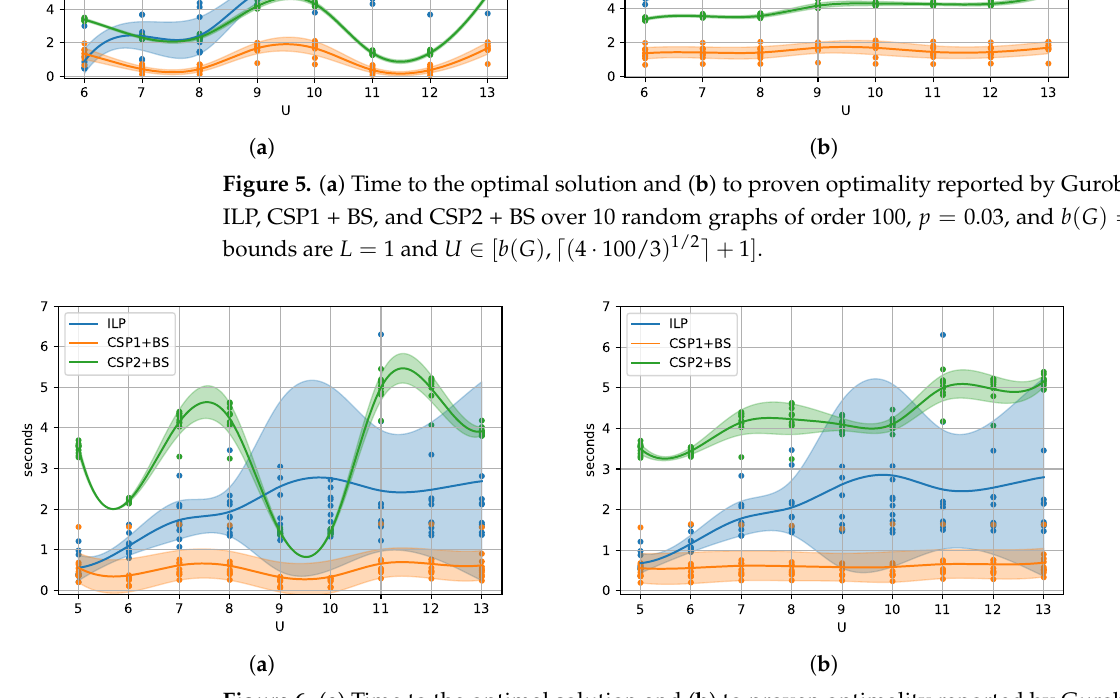
Figure 6. ( a ) Time to the optimal solution and ( b ) to proven optimality reported by Gurobi for the ILP, CSP1 + BS, and CSP2 + BS over 10 random graphs of order 100, p = 0.04, and b ( G ) = 5. The bounds are L = 1 and U ∈ [ b ( G ) , (cid:100) ( 4 · 100/3 ) 1/2 (cid:101) + 1 ]